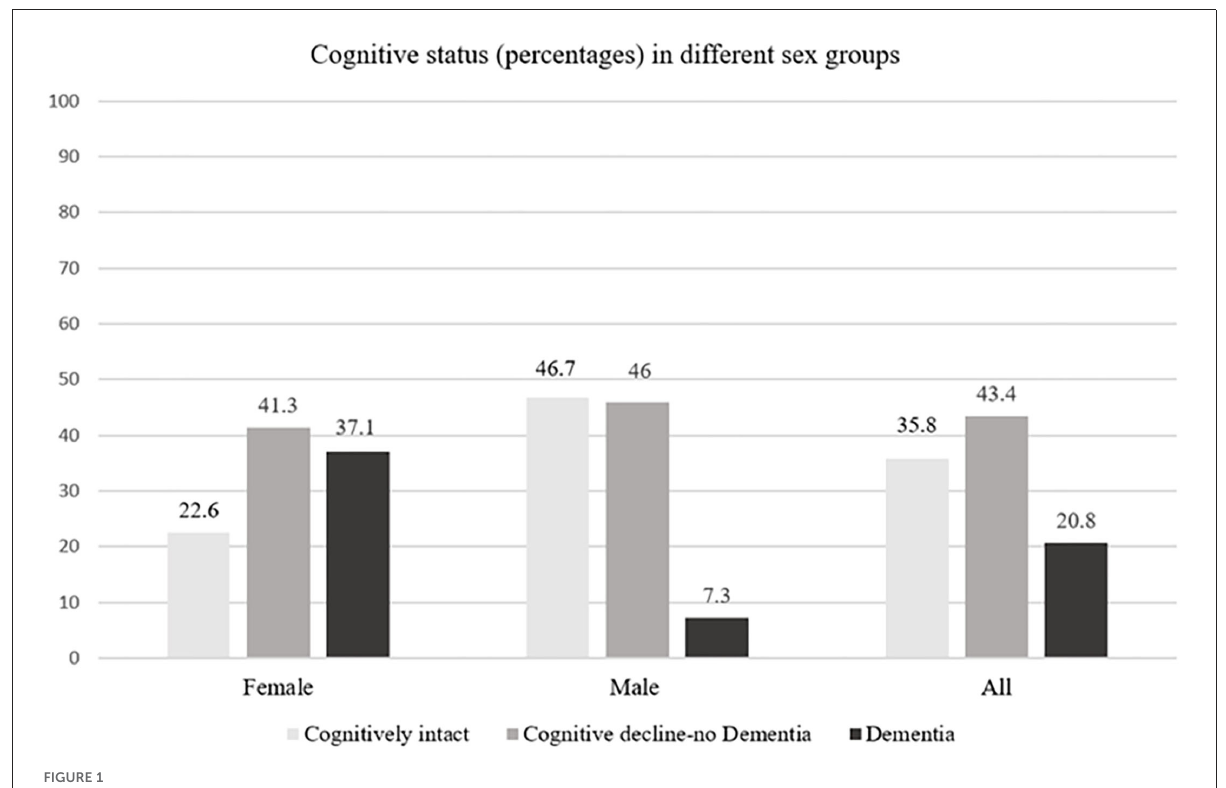
FIGURE1 Distribution of cognitive status in female patients, male patients, and all patients with